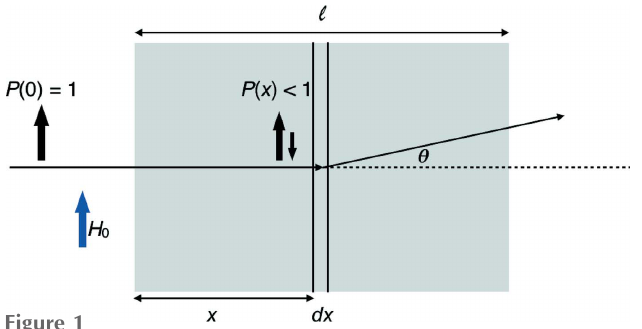
Figure 1 A polarized neutron beam traversing a sample of length l under an external magnetic field H 0 is scattered at a distance x